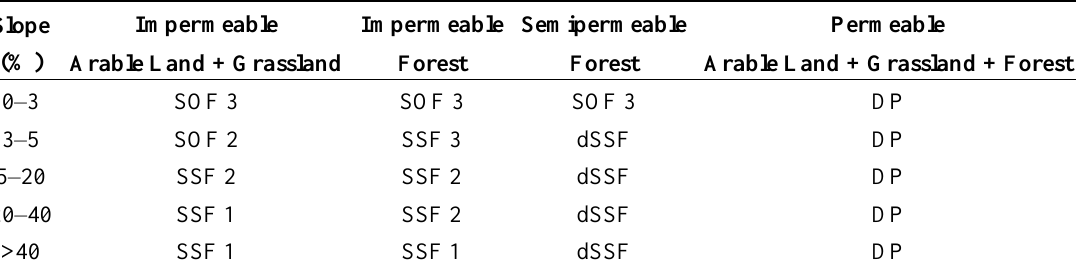
Table 6. GIS-DRP table semipermeability